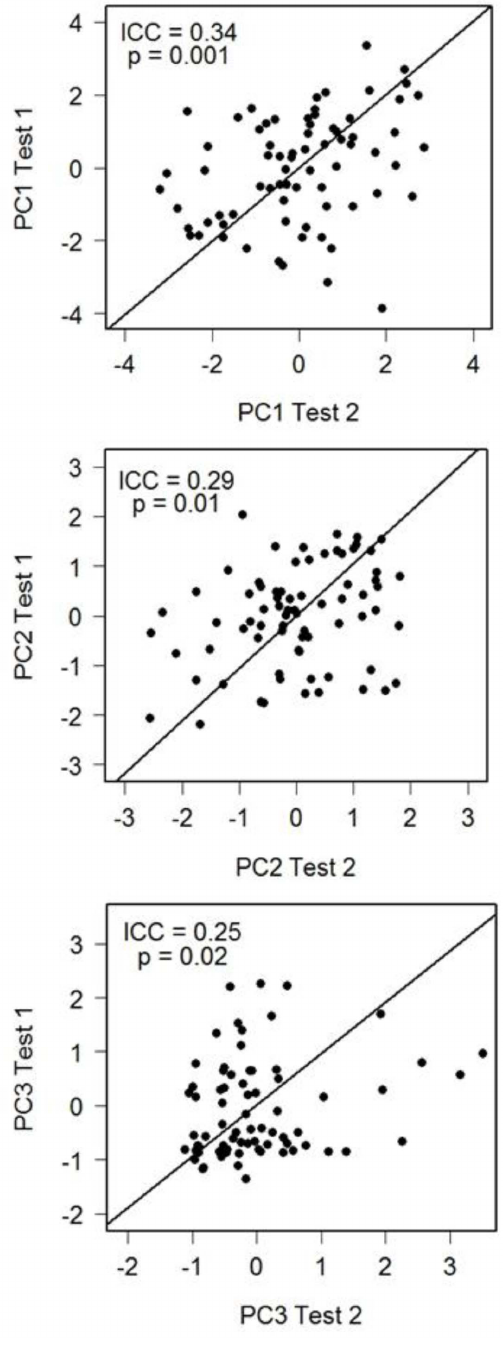
Figure 2. Scatterplots demonstrating repeatability of (a) PC1, (b) PC2 and (c) PC3 between behavioural trials 1 and 2 for 76 little brown bats in a novel environment test. Note that reduced- major-axis regression lines are plotted to illustrate the relationship, but repeatability was assessed using an intra-class correlation.